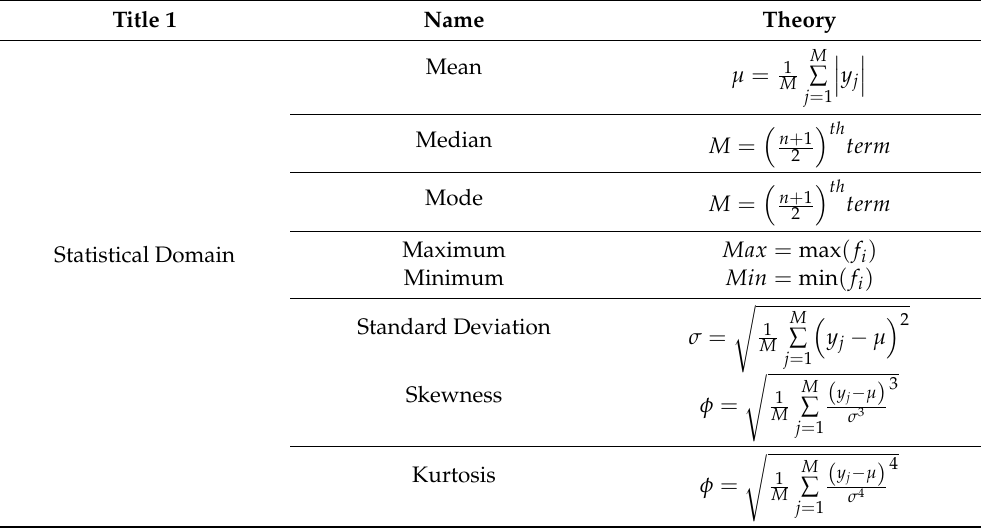
Table 1. Summary of Statistical Parameters deployed in this